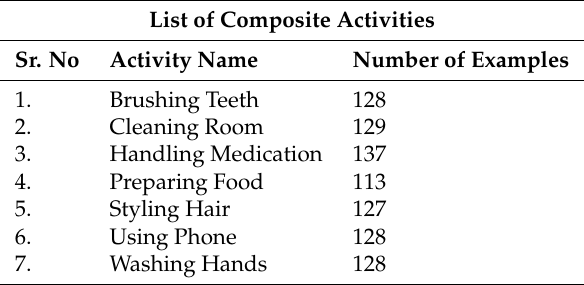
Table 1. List of composite activities and the number of